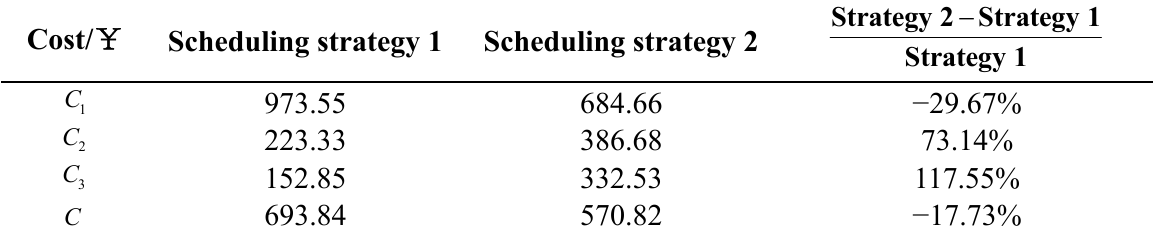
Table 6. Grid-connected mode: cost of dispatch results under different